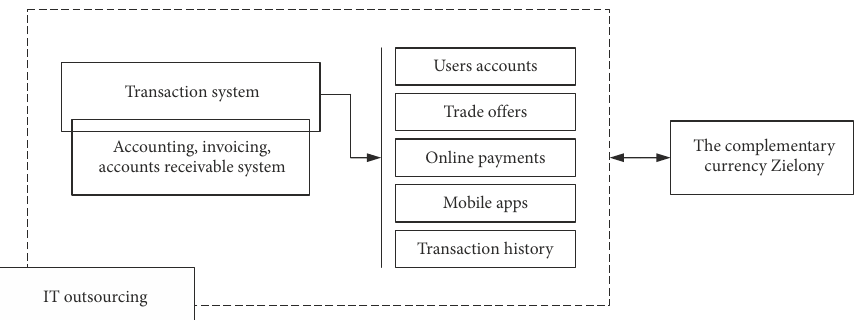
Figure 1. Architecture of the complementary currency system Zielony (source: own elaboration)